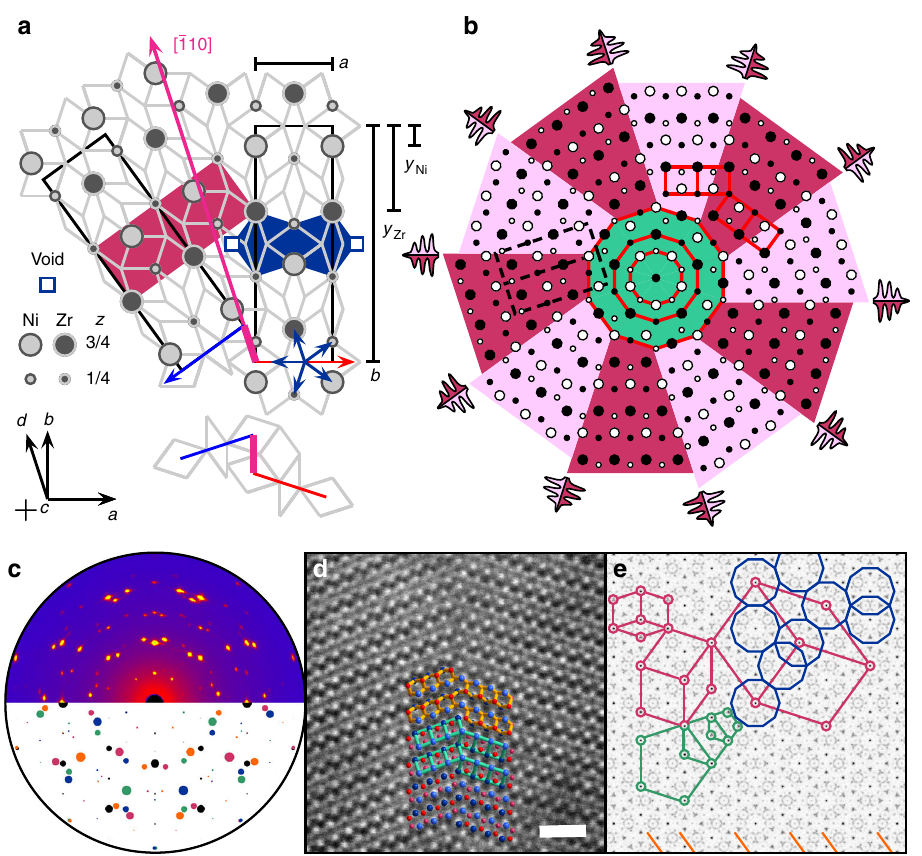
Fig. 3 Atomic structure of the tenfold twin. a Coherent twin boundary constructed from a rhombic Penrose tiling, its vertices described by a pentagonal Z module (dark blue star of arrows). A pair of defective pentagons (dark blue) contains formal defects, not to be confused with structural vacancies (!), being attributed to geometric frustration regarding the alternating height of atoms in the c -direction. Structural units (dark red) are coherent across the twin boundary (magenta). b Patch of the tenfold twin with its chiral and polar domain structure (light and dark red), showing coherent structural motifs across the twin boundary (solid red and dashed black), and its quasicrystalline core (green), with τ scaled decagons (red). The schematic onset points of dendrite growth are highlighted. c Measured (top) and calculated (bottom) X-ray diffraction pattern. d HAADF-STEM micrograph of a coherent twin boundary and its overlayed structure model (Ni light/dark red, Zr light/dark blue, interatomic contacts yellow and tortoise, scale bar 1 nm). e Fourier transform of the point pattern in b exhibiting relations to the rhombic Penrose tiling (red), pentagonal in fl ation symmetry (green), decagonal cluster coverings (blue), golden ratio spacings (orange) — tell-tale features of long-range orientational order associated with decagonal